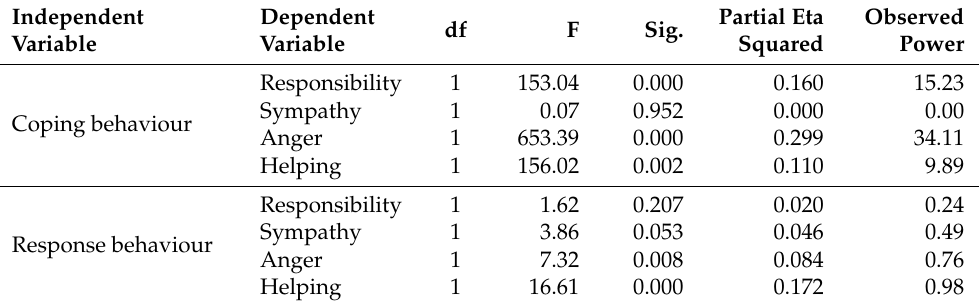
Table 1. Effects of Target Coping Behaviour and Perpetrator Response Behaviour on Perceptions of the Target.